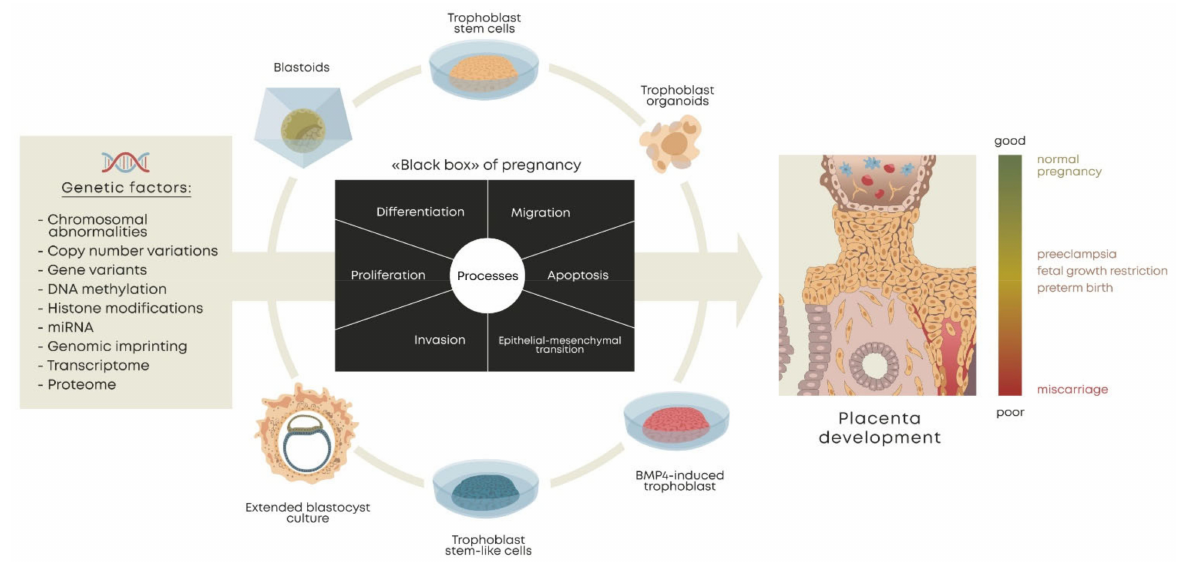
Figure 1. Stem cell-based technologies for the study of human trophoblasts and placental develop- ment. Genetic factors affect proper human embryo development and pregnancy success. Many pro- cesses in early development are hidden in the “black box” of human implantation [1]. Stem